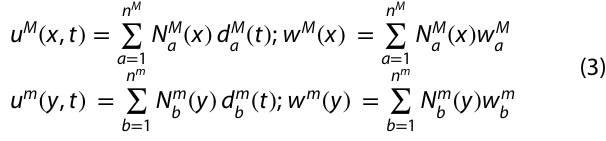
Fig. 3 Homogenization method: a microstructure observation; b representative volume element (RVE) with scale